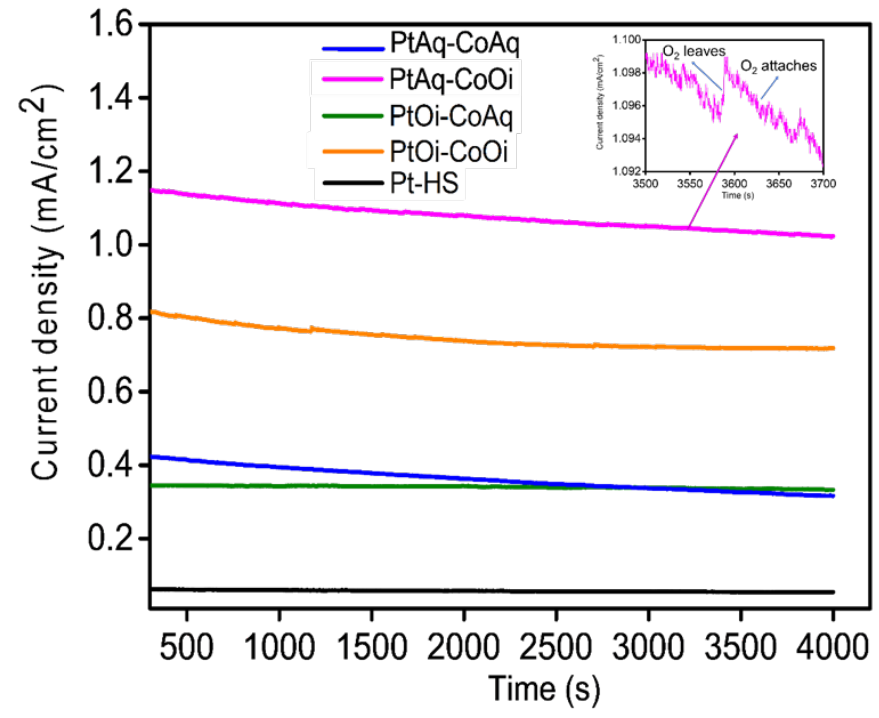
Figure 7. The current density-time curves for PtAq-CoAq, PtAq-CoOi, PtOi-CoAq, PtOi-CoOi and Pt-HS in 0.1 M KOH at 1.50 vs. RHE.